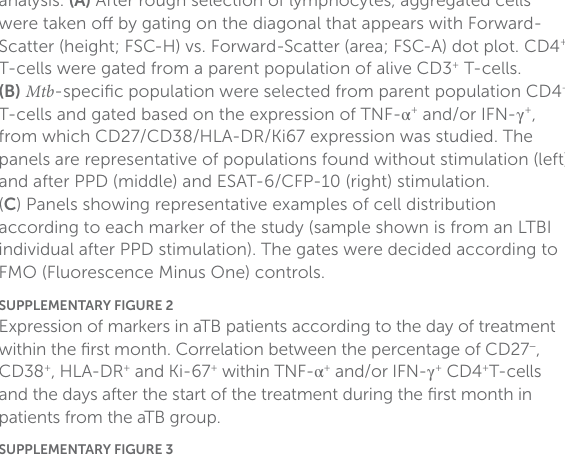
SUPPLEMENTARY FIGURE 5 Strong correlation between the percentage of CD27 − in TNF- α + and/or IFN- γ + CD4 + T-cells and the CD27 MFI ratio after ESAT-6/CFP-10 (left) and PPD (right) stimulation. Correlation was calculated using the two-